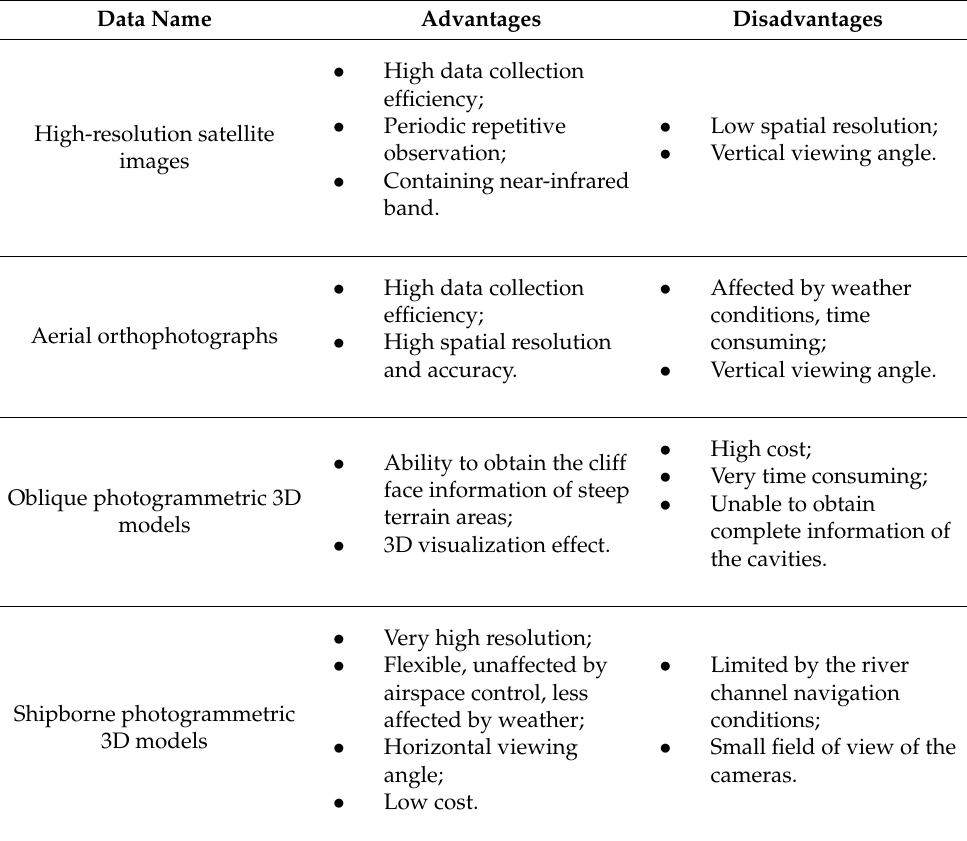
Table 6. Advantages and disadvantages of different remote sensing data on landslide detection in the